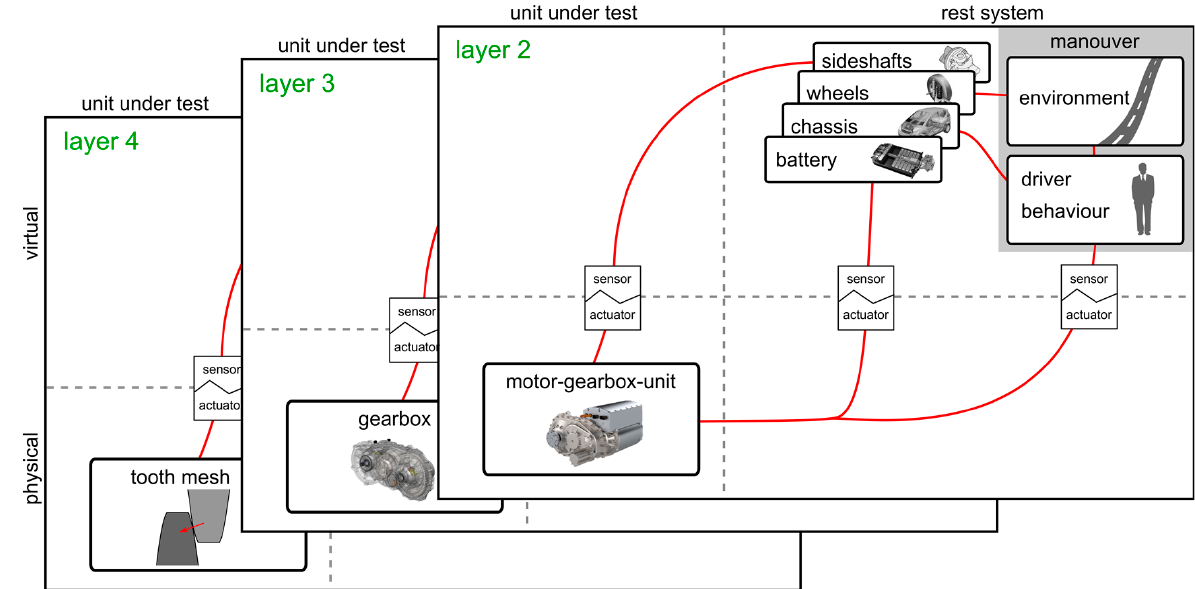
Figure 2. XiL system layout.